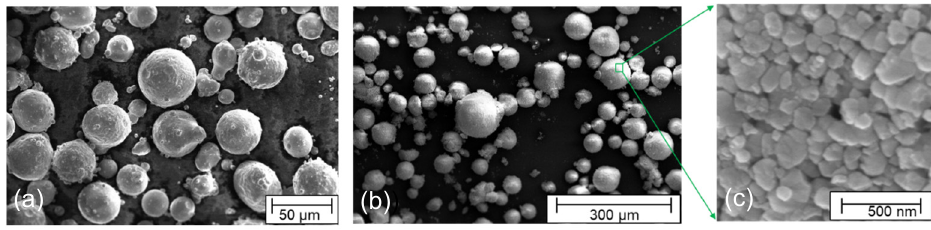
Figure 1. SEM images of ( a ) 17-4PH particles, ( b ) 3Y-TZP granulates, and ( c ) 3Y-TZP particles.